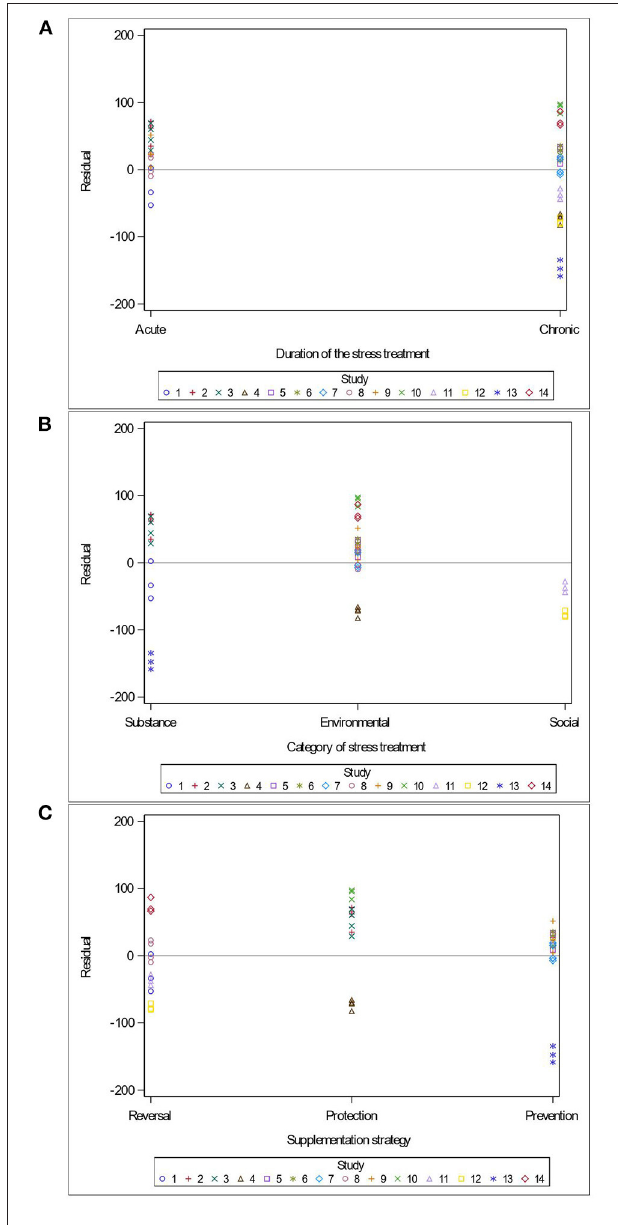
FIGURE 5 | Raw residuals of Model 3 (Supplementation*Stress) plotted against duration of the stress treatment (A) , category of stressors (B) , the treatments order (C) where points represent treatment means and are coded by